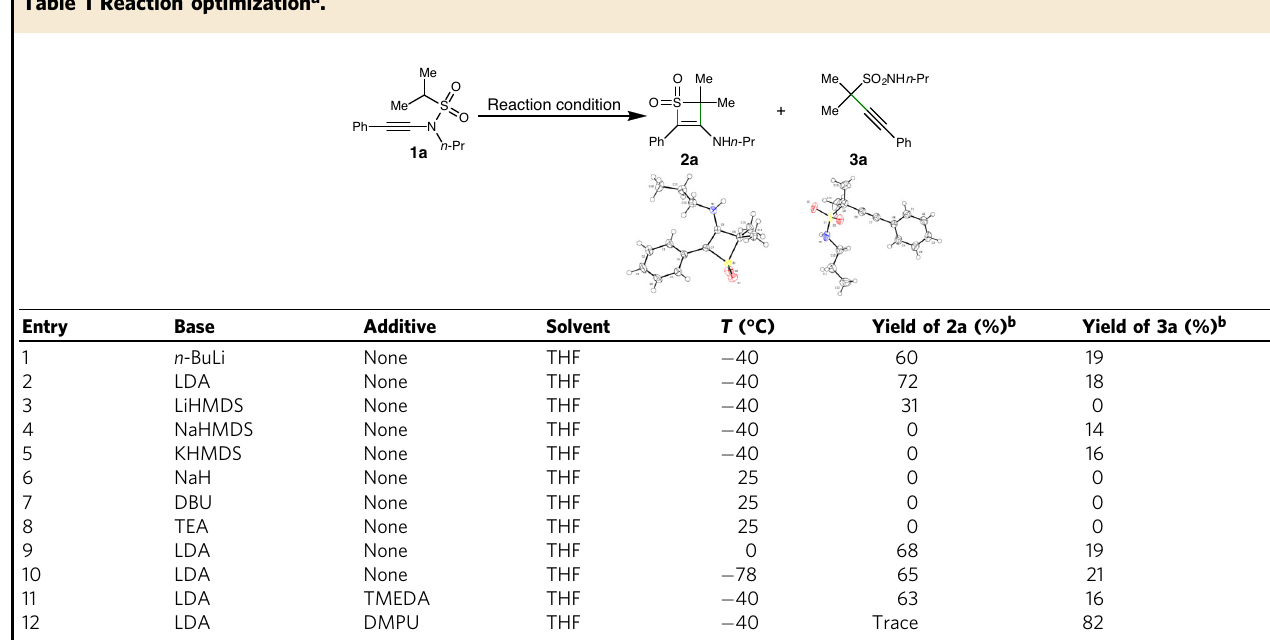
Table 1 Reaction optimization a .